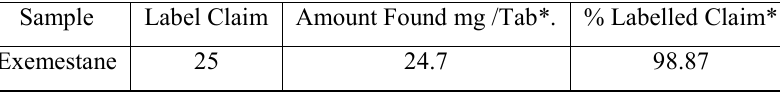
Table 4. Determinations of Active Ingredients in Tablets.